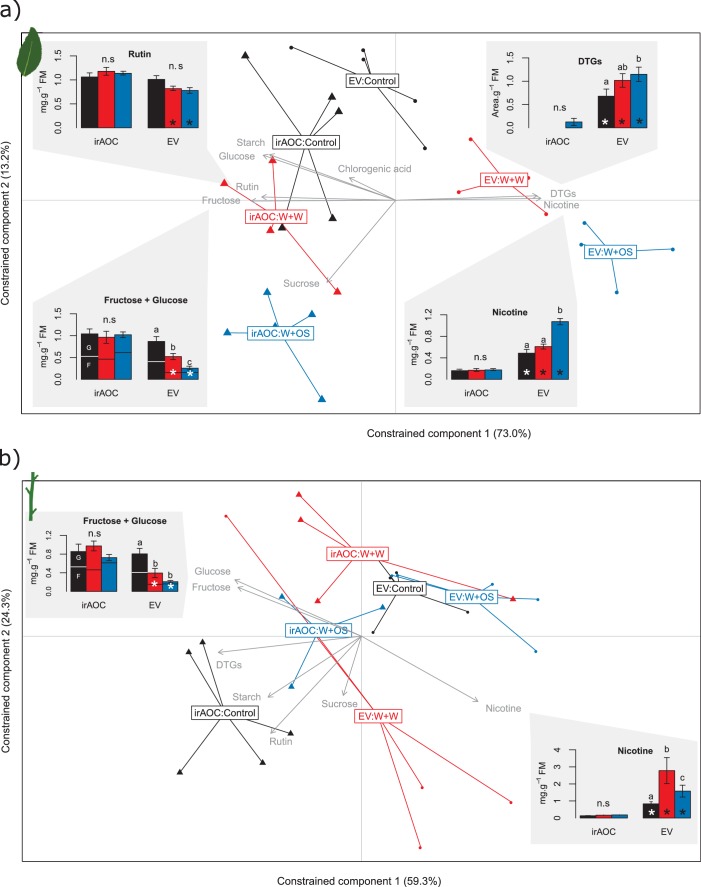
Herbivory-induced jasmonates increase secondary metabolites and decrease sugars in leaves and stems.Results of a redundancy analysis of the metabolic profiles in the leaves (a) and in the stems (b) of wild type (EV) and jasmonate-deficient (irAOC) plants are shown (n = 3–5). Insets depict average (±SE) concentrations of metabolites explaining most of the variation between induced EV plants and the other treatment*genotype combinations (correlation coefficients > |0.8|). Letters indicate significant differences between treatments within genotypes (p<0.05). Asterisks indicate significant differences between genotypes within treatments (p<0.05). Control: intact plants; W+W: wounded and water-treated plants; W+OS: wounded and M. sexta oral secretions-treated plants; DTGs: diterpene glycosides.DOI:
http://dx.doi.org/10.7554/eLife.13720.01410.7554/eLife.13720.015Figure 3—source data 1.Plant primary and secondary metabolite concentrations.